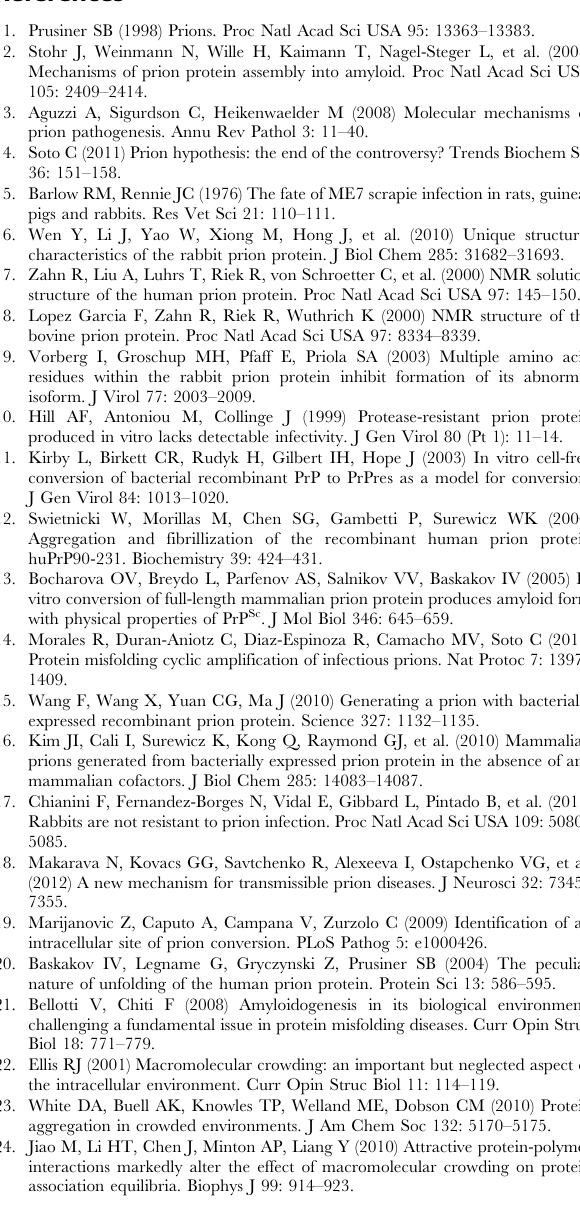
Table S1 The primers used to replace the human PrP-H2H3 by the rabbit PrP-H2H3. Table S2 The primers used to replace the rabbit PrP-H2H3 by the human PrP-H2H3. Table S3 The primers used to construct chimera H in which the human PrP-B1H1B2 ( b -strand 1, a -helix 1, and b -strand 2) was replaced by the rabbit PrP-B1H1B2.